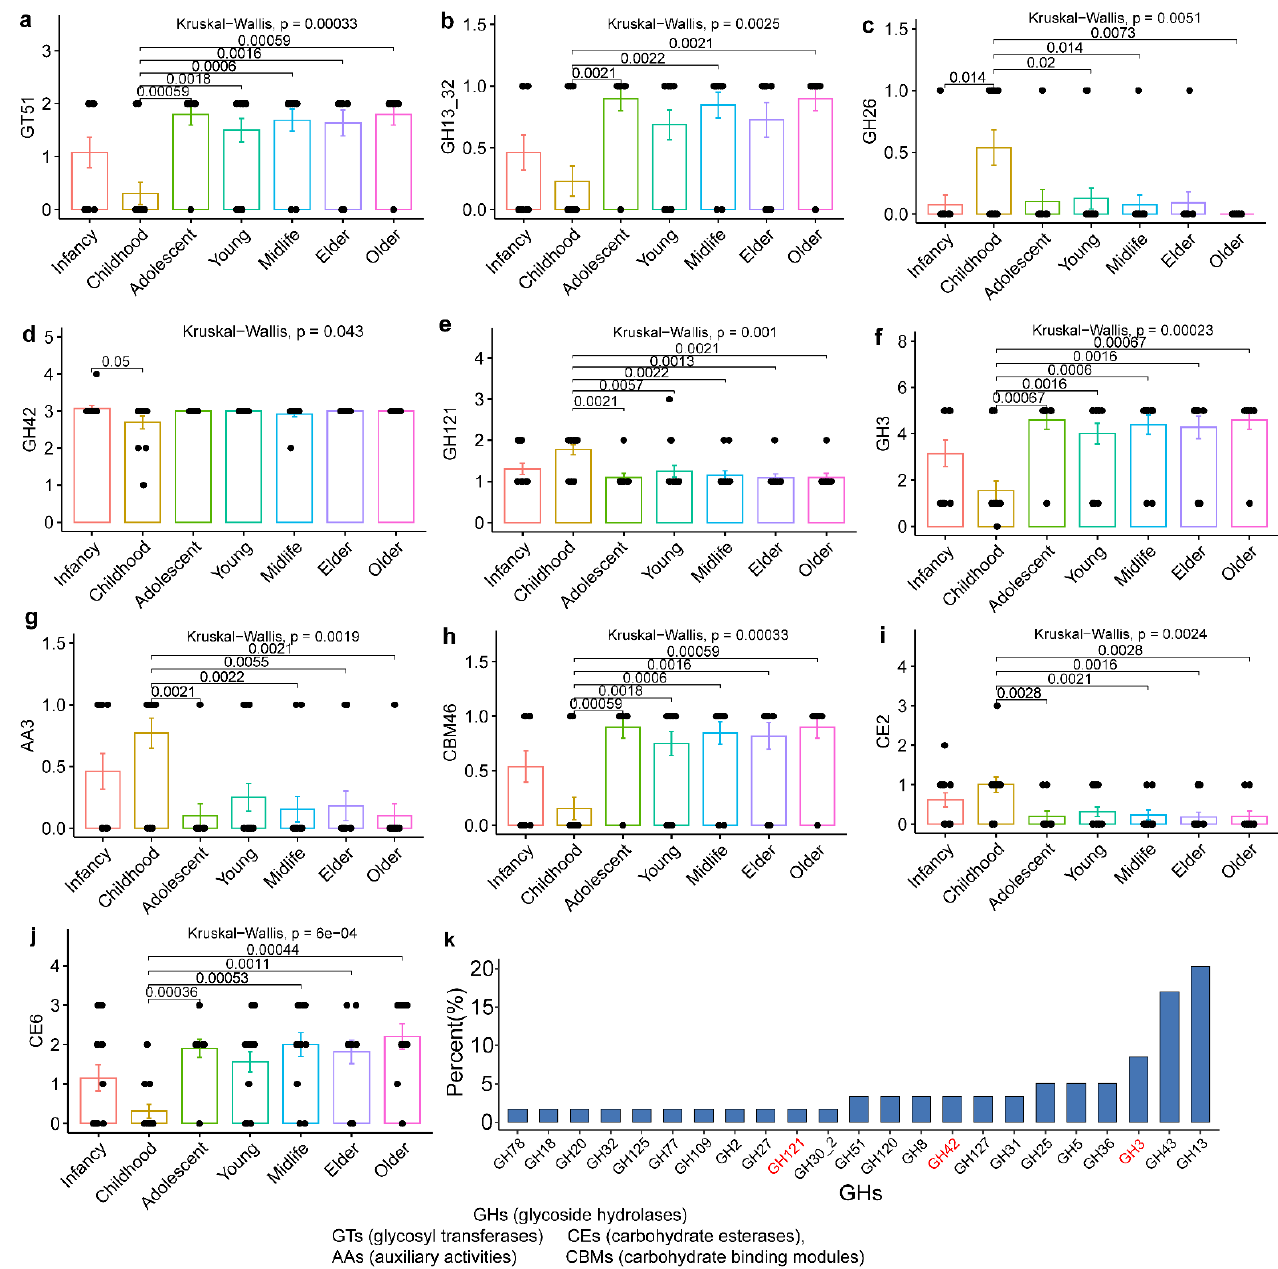
Figure 3. The number of carbohydrate-active enzyme in different age groups ( a – j : infancy: 0 – 1.5 years, childhood: 1.5 – 3.5 years, adolescent: 4 – 18 years, young: 21 – 45 years, midlife: 47 – 60 years, elder: 65 – 79 years, older: 80 – 108 years; GHs (glycoside hydrolases), GTs (glycosyl transferases), CEs (carbohydrate esterases), AAs (auxiliary activities) and CBMs (carbohydrate binding modules)). Percent (%) as percentage of all GHs within 88 Bifidobacterium pseudocatenulatum strains. Each solid black dot represents a strain. ( k ). Significant testing was performed using Wilcoxon rank sum test ( p < 0.05). Red words as a significant difference marker of GHs in different age groups.